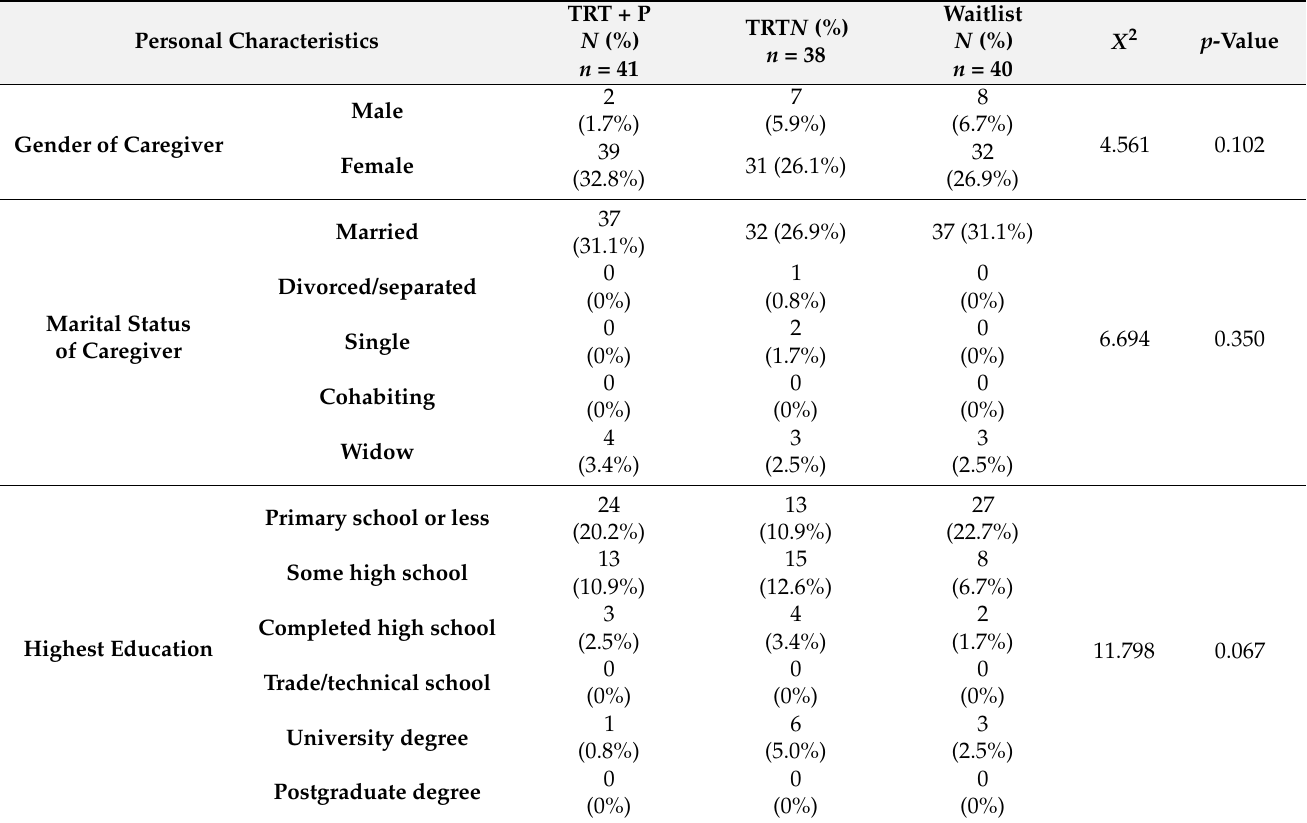
Table 1. Demographic characteristics of study participants at